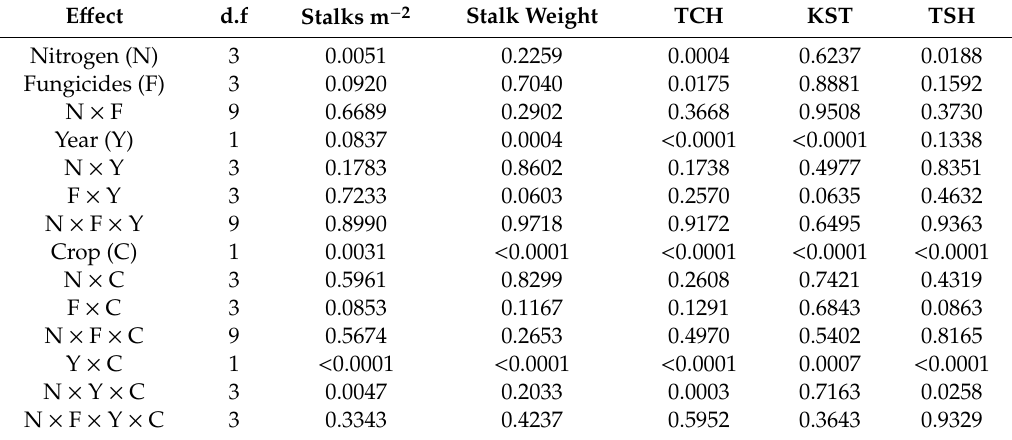
Table 7. Fixed e ff ects on ANOVA p -values of nitrogen, fungicides, year, crop, and their interaction e ff ects on sugarcane yield attributes and yields with a combined dataset of plant and ratoon crops. E ff